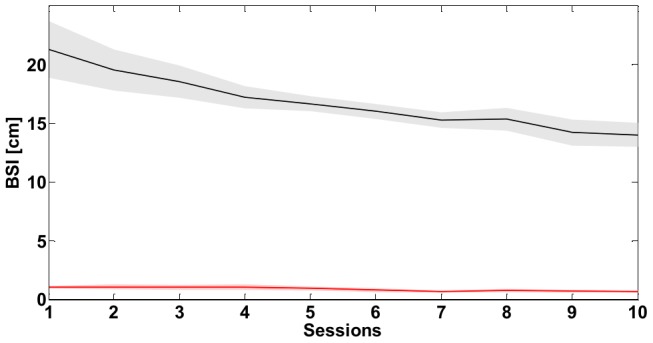
Task A: Bimanual Separation Index (BSI).Evolution of the BSI throughout the ten sessions of training. The continuous line is the mean value over the eight subjects while the shaded area corresponds to the standard error. The black line refers to the SSS while red one to the PSS.